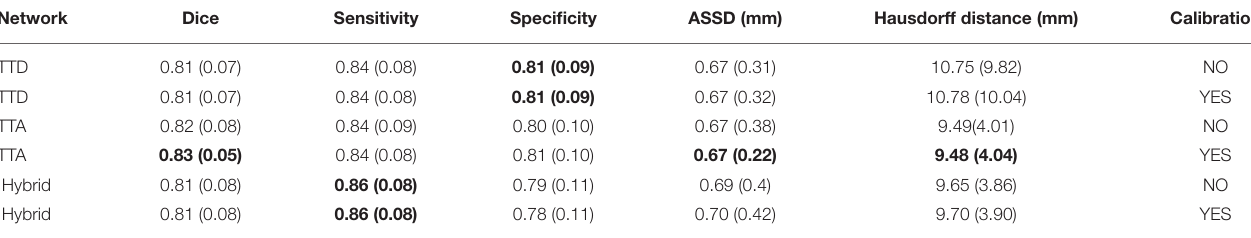
TABLE 4 | Segmentation metrics for 21 random subjects in the test set.